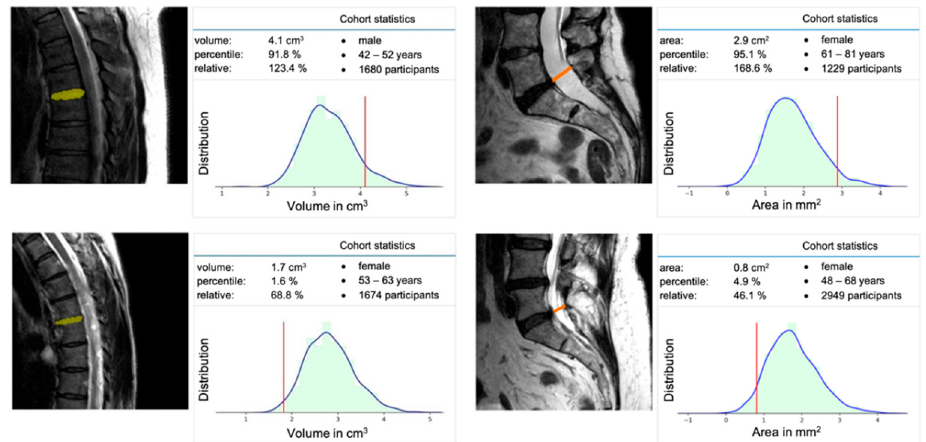
Figure 5. Screenshot from the software tool with quantitative evaluation of the intervertebral disc volume in correlation to the corresponding age and sex cohort ( left ). Quantitative evaluation of the minimal paraxial spinal canal area at the level of L5/S1 in correlation to the corresponding age and sex cohort ( right ).